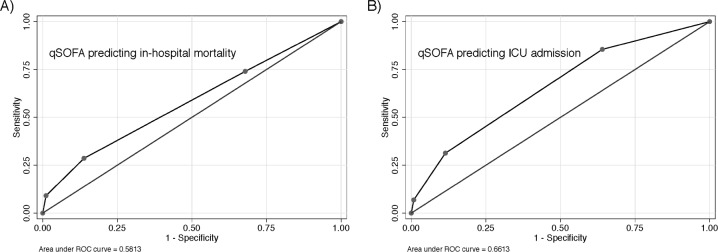
Receiver operating characteristic curve of qSOFA predicting A) in-hospital mortality, B) ICU admission.